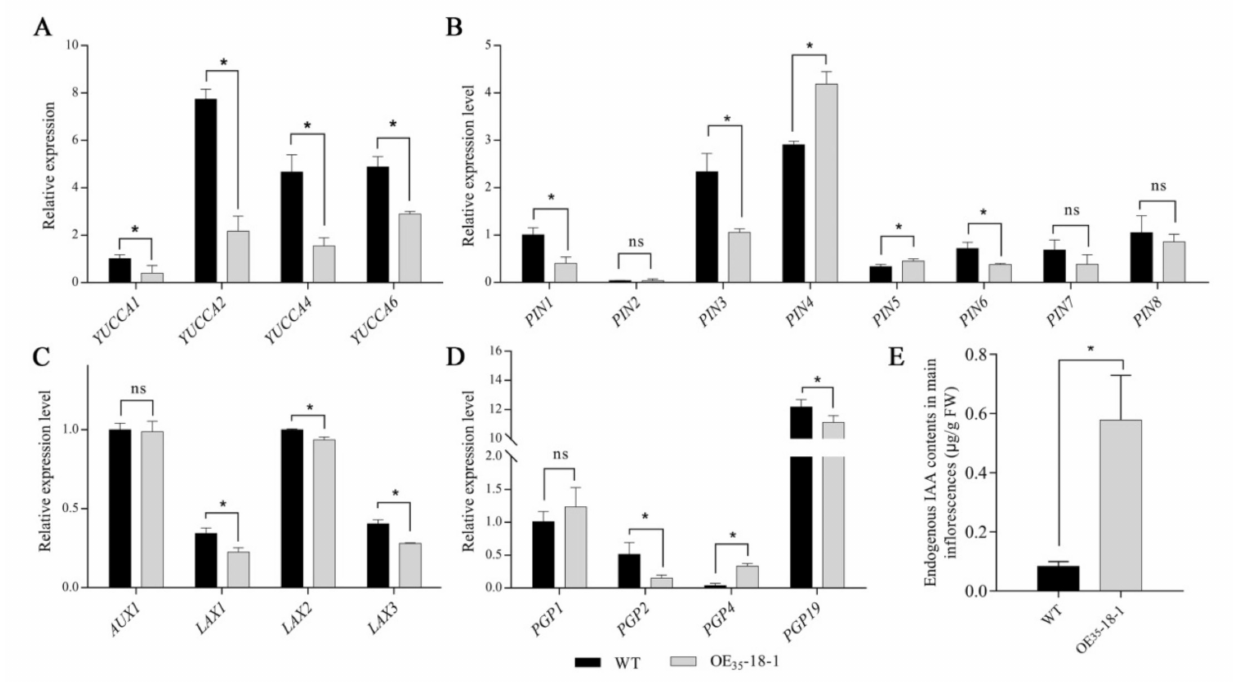
Figure 7. Relative expression levels of IAA-related genes and endogenous IAA level in main in- florescence of transgenic plants. ( A ) relative expression levels of four YUCCA genes ( AtYUCCA1 [ At4g32540 ], AtYUCCA2 [ At4g13260 ], AtYUCCA4 [ At5g11320 ], and AtYUCCA6 [ At5g25620 ]); the expression level AtYUCCA1 in the wild-type (WT) being set as a unit. ( B ) relative expression levels of eight PIN family genes ( AtPIN1 [ At1g73590 ], AtPIN2 [ At5g57090 ], AtPIN3 [ At1g70940 ], AtPIN4 [ At2g01420 ], AtPIN5 [ At5g16530 ], AtPIN6 [ At1g77110 ], AtPIN7 [ At1g23080 ], and AtPIN8 [ At5g15100 ]); the expression level of AtPIN1 in the WT being set a unit. ( C ) relative expression level of four AUX/LAX family genes ( AtAUX1 [ At2g38120 ], AtLAX1 [ At5g01240 ], AtLAX2 [ At2g21050 ], and AtLAX3 [ At1g77690 ]), and the expression level of AtLAX2 in the WT being set as a unit. ( D )